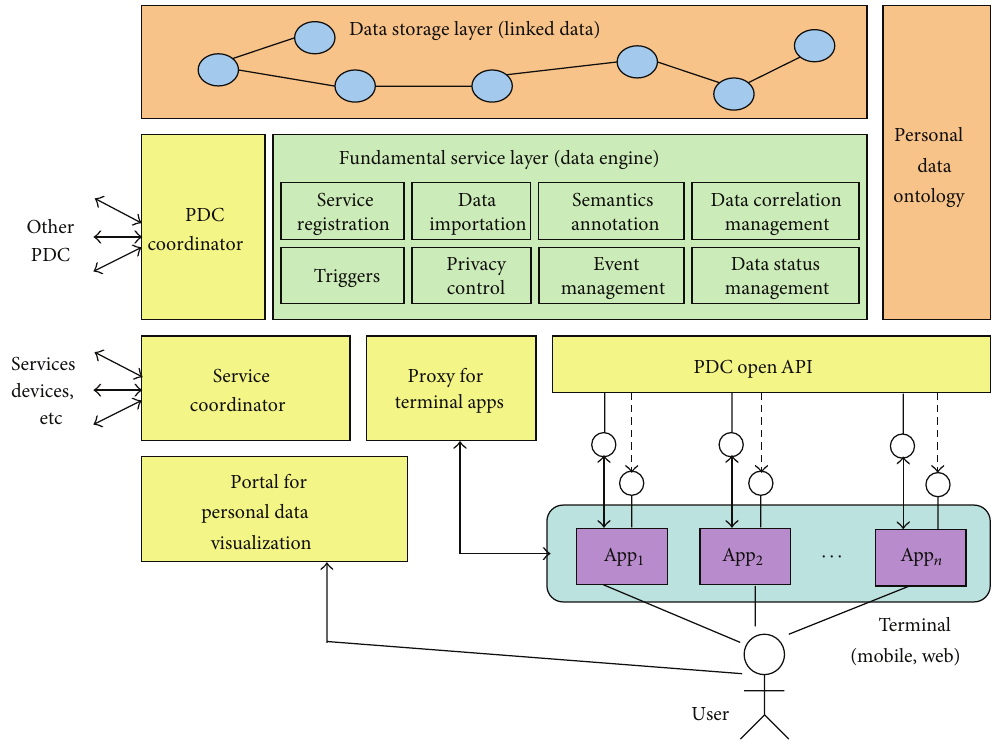
Figure 4: A reference architecture of